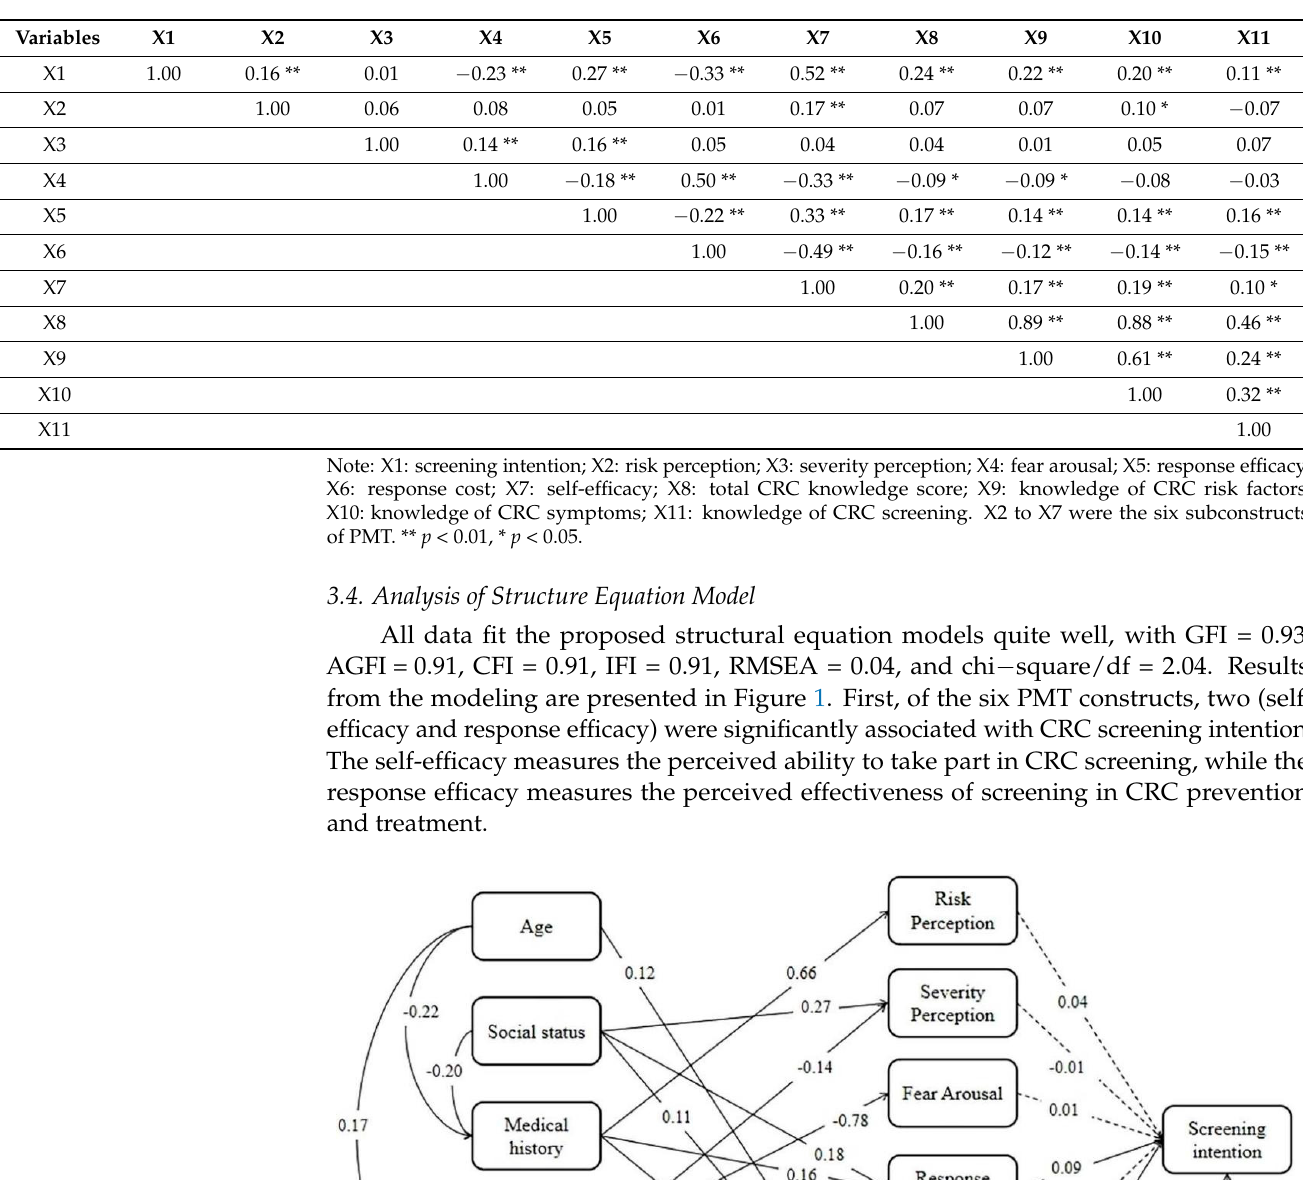
Table 3. Inter-correlations for the screening intention and some variables.